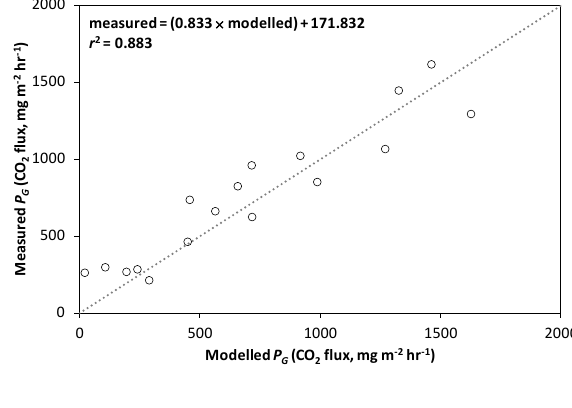
Figure 3. Measured vs modelled gross photosynthesis ( P ) for one of the collars at the G North Wales blanket peatland site. The dotted line is the 1:1 line. Note that for the purposes of plotting, P has been given as positive values. G